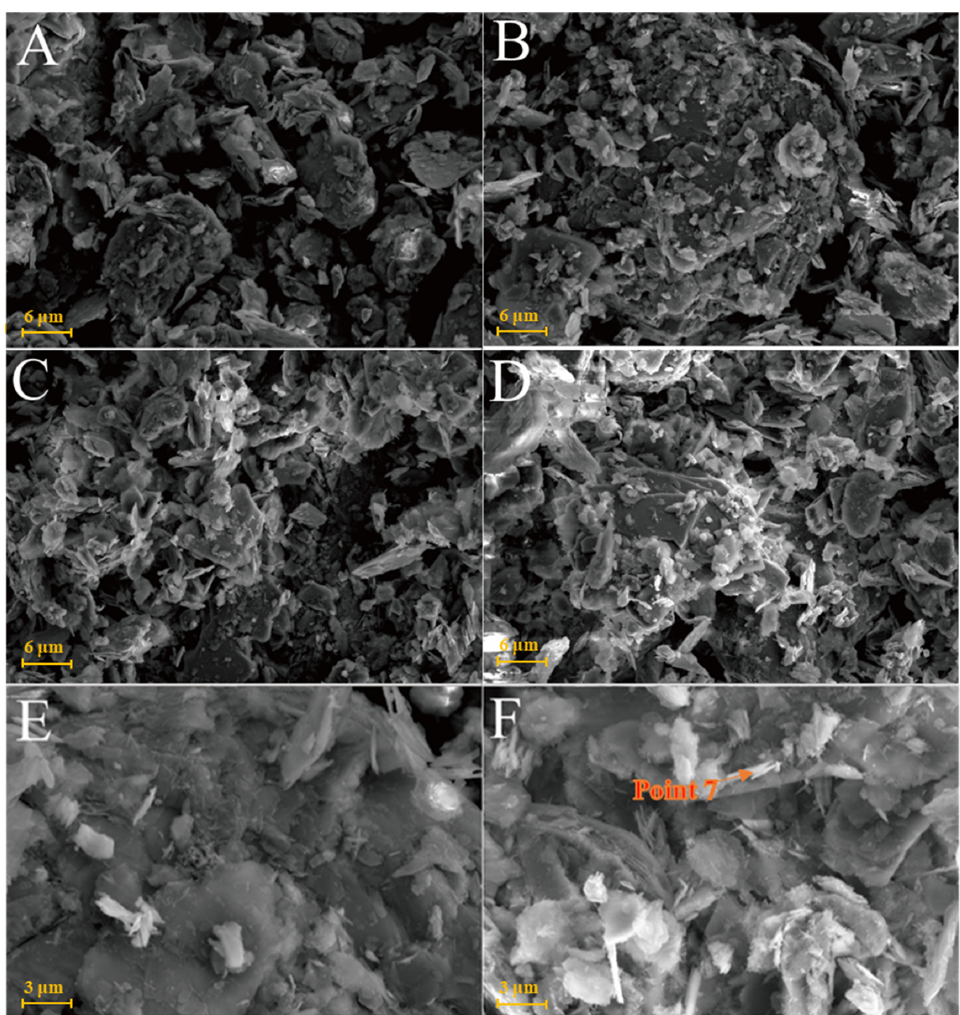
Figure 10. SEM images of chlorite samples: ( A )—chlorite raw material; ( B )—L0 samples cured for 3 days; ( C )—L0 samples cured for 7 days; ( D )—L0 samples cured for 28 days; ( E )—L0-2 samples cured for 3 days; ( F )—L0-2 sample cured for 28 days. Table 2. EDS dotting analysis of clay samples (Atomic percentage %).